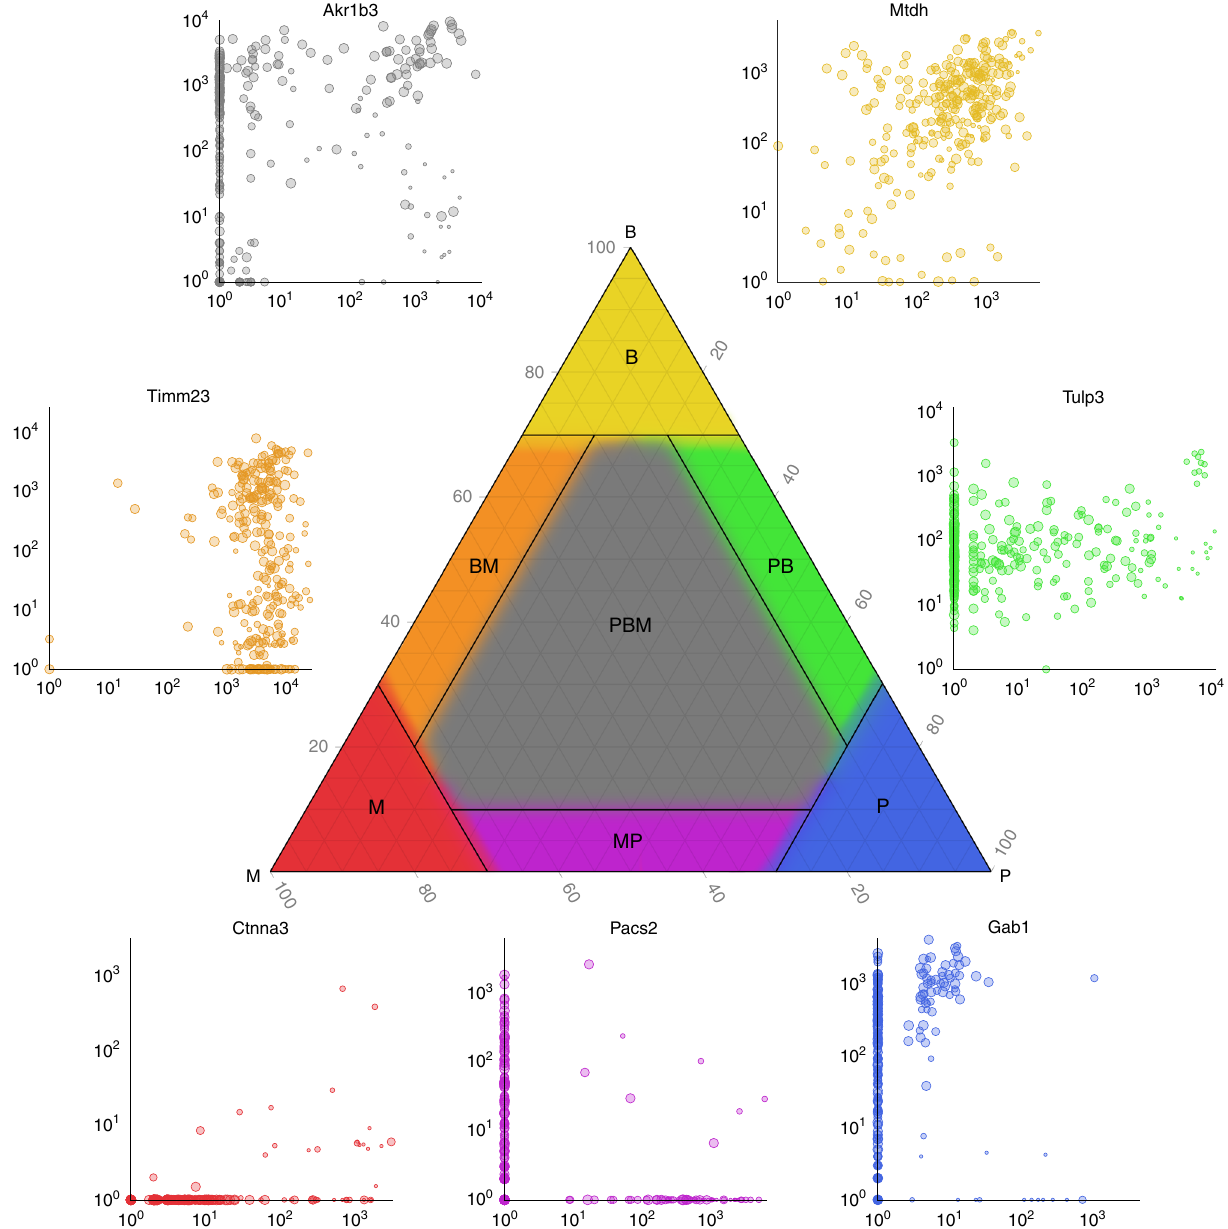
Fig. 6 Classi fi cation of allele-speci fi c expression patterns across cells. For each gene in each cell, the classi fi cation step of scBASE estimates allelic state probabilities π s , where s indicates paternal monoallelic (P), bi-allelic (B), or maternal monoallelic (M) expression. The average proportions of cells in each gk allelic state ( π s ) can be represented as a point in a triangular diagram, which is a 3D simplex generated by projecting out the no-expression dimension g (cid:3) from the 4D simplex in Fig. 4a. A gene that is predominantly paternal, bi-allelic, or maternal across the cell population will be plotted near the corresponding vertex. Points representing genes with mixed classi fi cation states across the cell population will appear along the edges or in the center of the triangle. We delineate seven patterns of allelic expression for a gene as indicated by the different colored regions in the diagram: P (blue), B (yellow), M (red), PB (green), BM (orange), MP (purple), and PBM (gray). Examples of genes from each pattern are shown as scatter plots of maternal and paternal read counts (log10 scale). Each point in the scatter plot corresponds to one cell ( n = 286 embryo cells). For example, the gene Pacs2 is expressed from either the maternal or the paternal allele but rarely both and is classi fi ed as an MP gene. The bi-allelic region ( B ) includes genes that may show allelic imbalance ( p gk ≠ 1 ) across many cells but consistently express both alleles (e.g., Mtdh ). The PB and BM regions will include genes that show a mixture of 2 bi-allelic expression and monoallelic expression. Many of the genes in these regions have strong allelic imbalance and cells with monoallelic expression could be due to statistical sampling zeros in the lower expressed allele (e.g., Tmim23 and Tulp3 ). The expression pattern in blastocyst cells for the majority of genes (57%) fall in the PBM region and display a pattern that is a mix of mono- and bi-allelic expression states across cells (e.g., Akr1b3